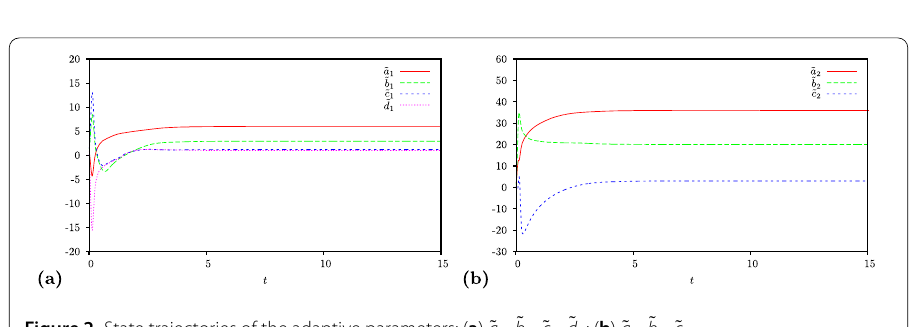
Figure 2 State trajectories of the adaptive parameters: ( a ) ˜ a 1 , ˜ b 1 , ˜ c 1 , ˜ d 1 ; ( b ) ˜ a 2 , ˜ b 2 , ˜ c 2